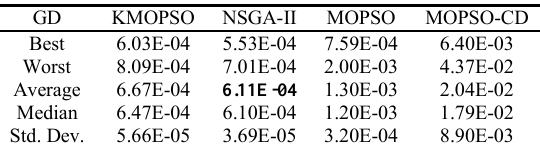
(c) Fig. 10. Box plots for the metrics of generational distance (a), Fig. 12. Box plots for the metrics of generational distance (a), spacing (b), maximum spread(c), KMOPSO (1), NSGA-II (2), spacing (b), maximum spread(c), KMOPSO (1), NSGA-II (2), MOPSO (3), MOPSO-CD (4). MOPSO (3), MOPSO-CD (4). Table 11 . Results of the generational distance metric for ZDT1. Table 14 . Results of the generational distance metric for GD ZDT3.